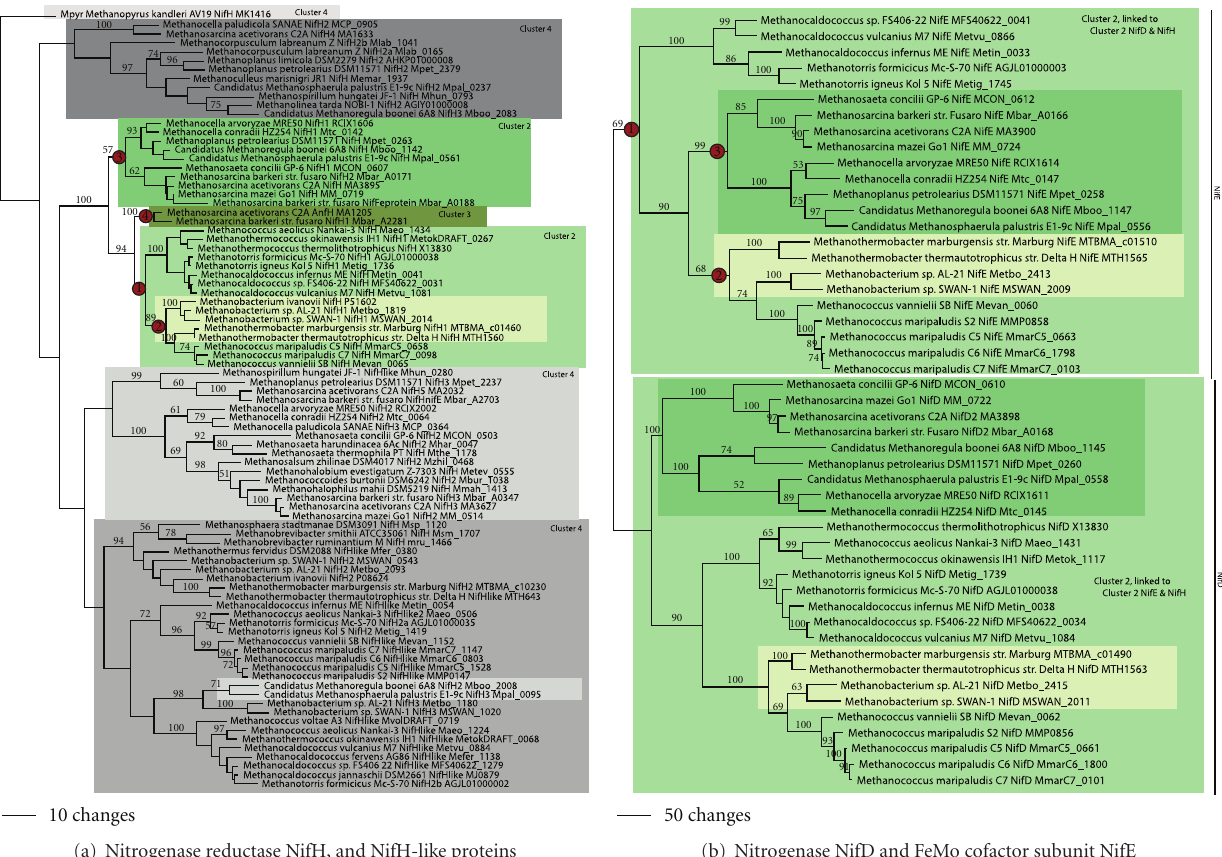
Figure 12: Nitrogen fixation. Phylogenetic trees for (a) nitrogenase reductase NifH and NifH-like proteins (type 4) and (b) the nitrogenase alpha subunit NifD with the FeMo cofactor subunit